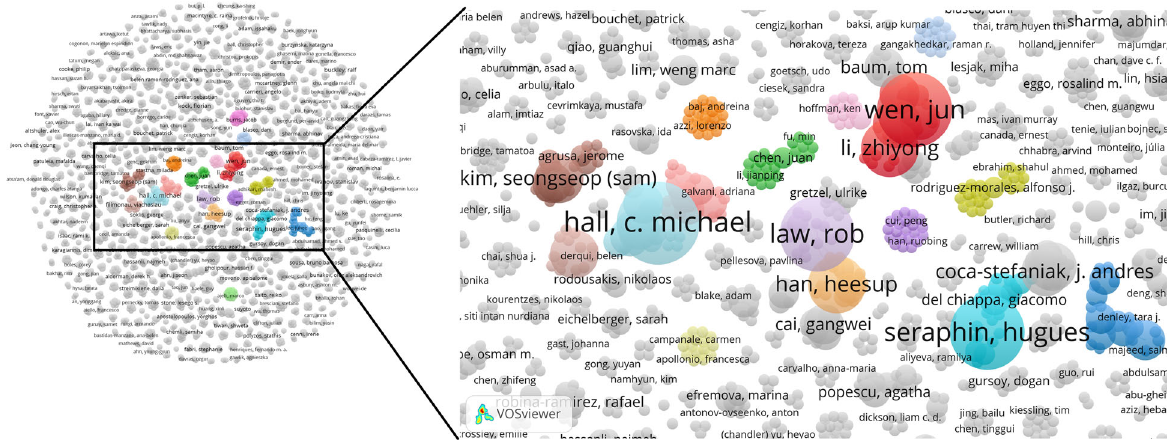
Fig. 3 Authors. Bibliographic coupling of authors network map on COVID-19 and